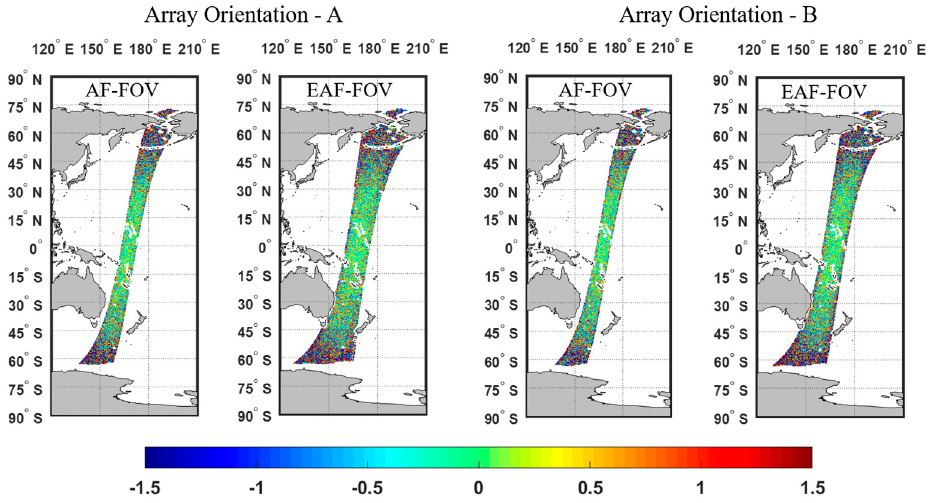
Figure 13. Illustration of the distribution of the SSS errors along one pass, considering case 2, i.e., of 1 °C. SST error and 2 m/s WS error in the SSS retrieval. The results of array orientation A and B with respect to the AF-FOV and EAF-FOV are presented separately. The color bar represents for the SSS retrieval errors in unit of psu.